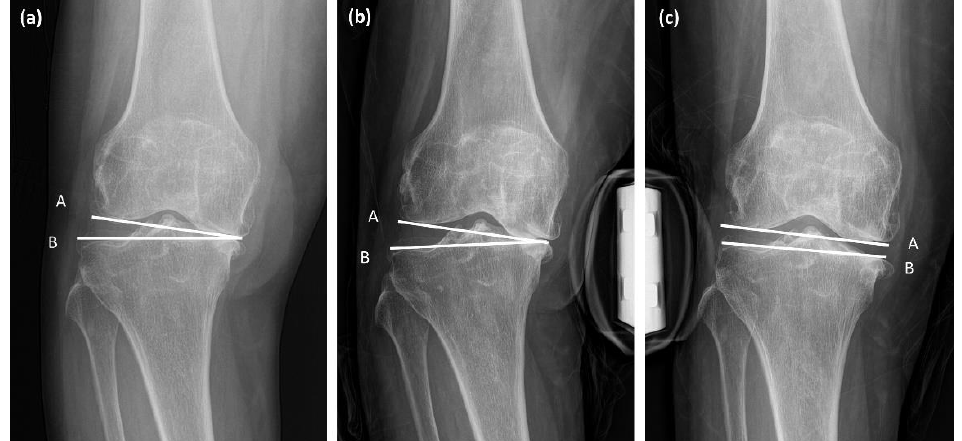
Figure 4. Measurement of joint line convergence angle (JLCA) and varus/valgus stress JLCA. Line A and B is the line connecting the articular surface of the distal femur and proximal tibia. ( a ) JLCA standing; ( b ) JLCA under varus stress; ( c ) JLCA under valgus stress.